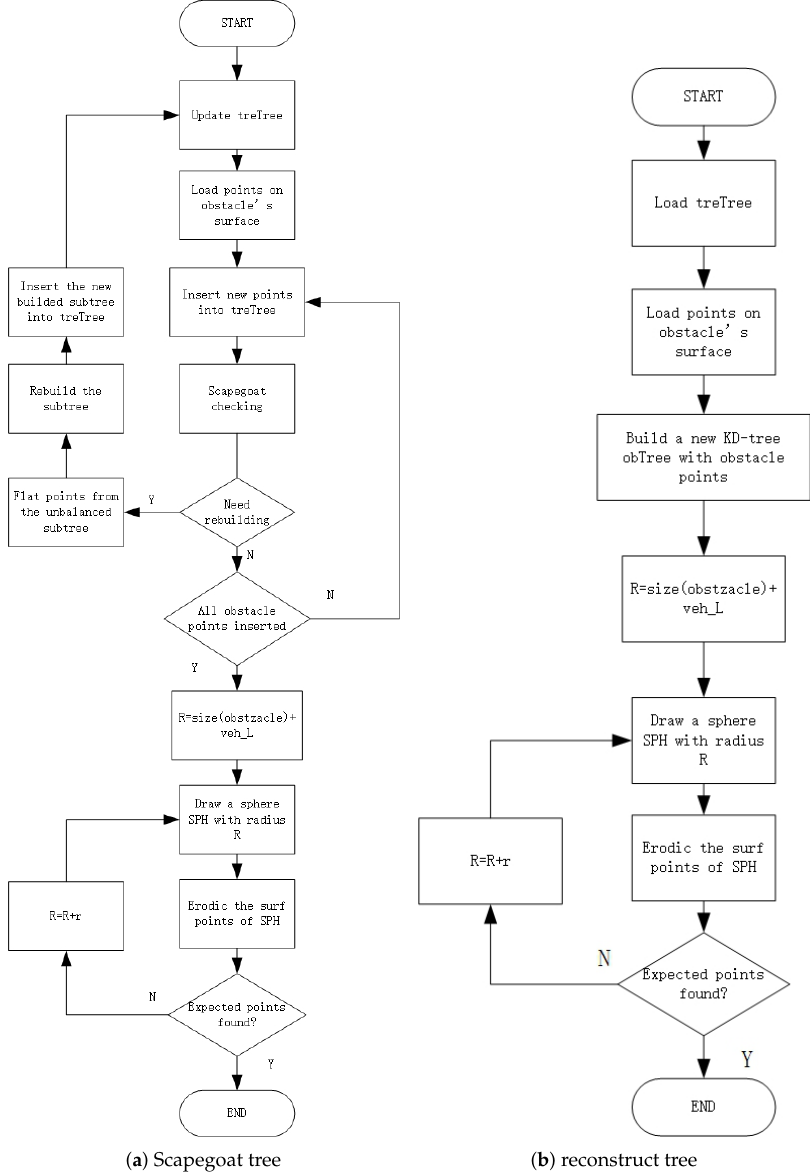
Figure 13. Flow Chart For obstacle avoidance, both the scapegoat tree and KD tree reconstruction methods are illustrated. In the scapegoat tree method, the obstacle spots are inserted into the original treTree , whereas the replanning method constructs a new KD tree from obstacle spots.